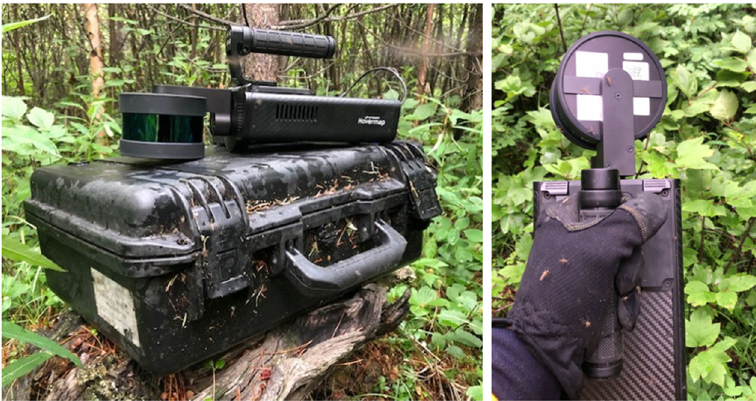
Figure 2. Side and top view of the Emesent Hovermap™ scanning system and carrying